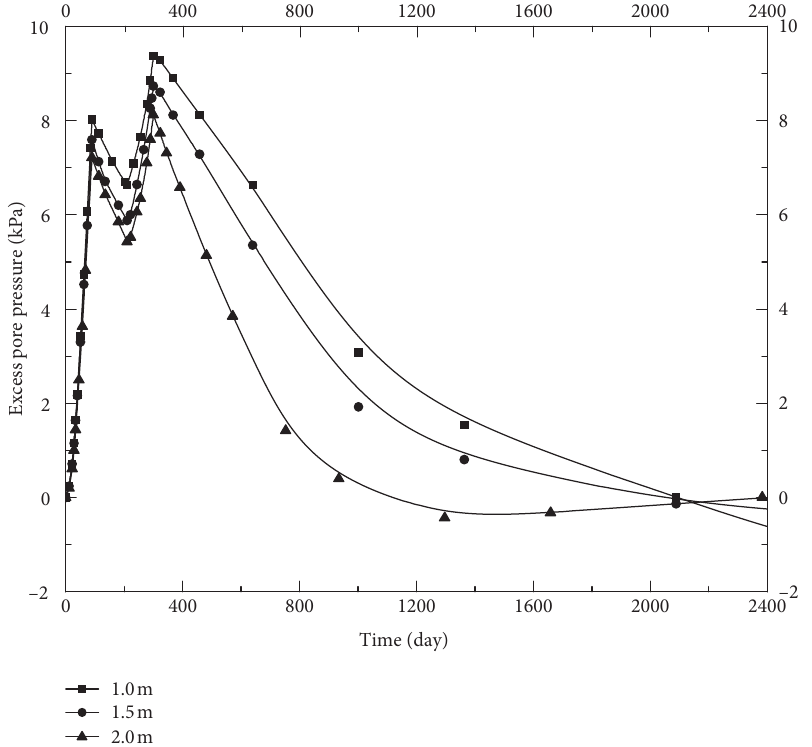
Figure 10: Excess pore pressure versus time with different thickness of crust.